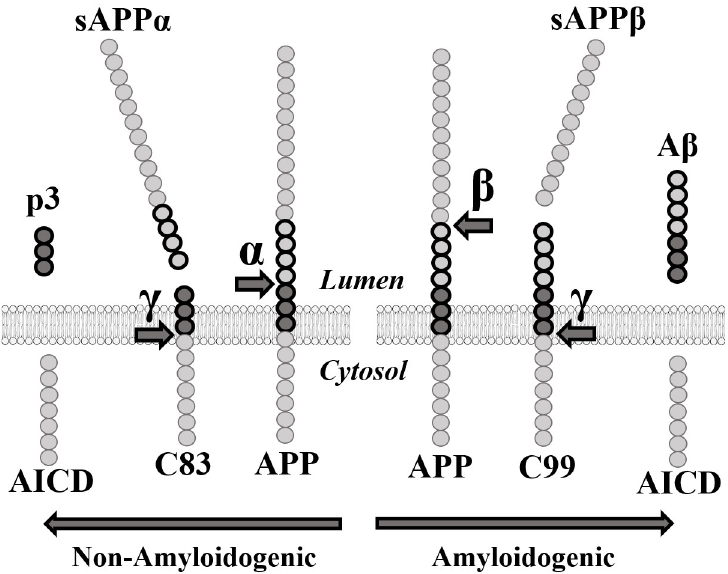
Fig 1. APP proteolytic pathways. α : α -secretase. sAPP α : soluble APP α fragment. β : β -secretase. sAPP β : soluble APP β fragment. γ : γ -secretase. AICD : APP Intracellular